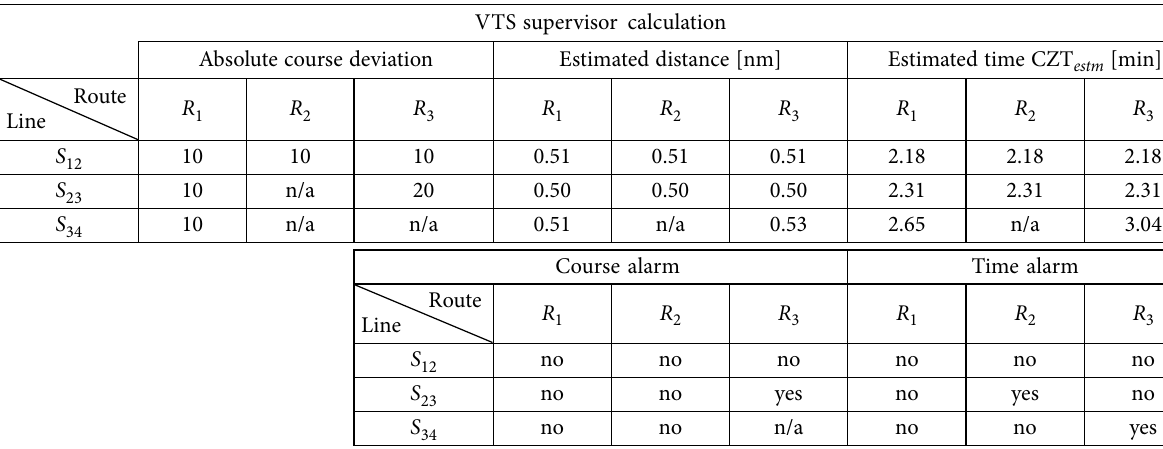
Table 2. Calculated data from the